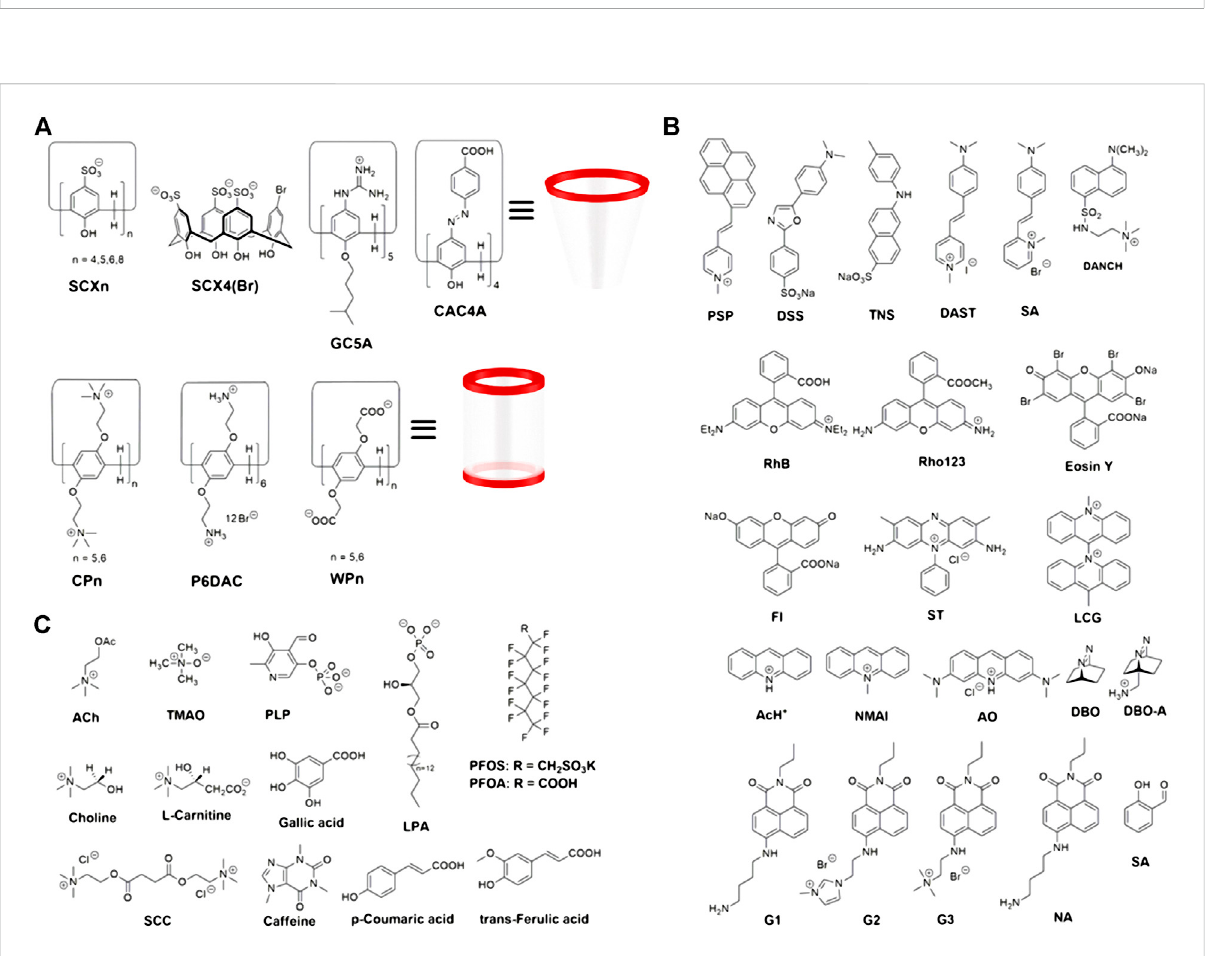
FIGURE 2 Chemical structures of (A) macrocyclic arenes as synthetic receptors, (B) fl uorophores as indicators and (C) partial analytes detected as competitors.